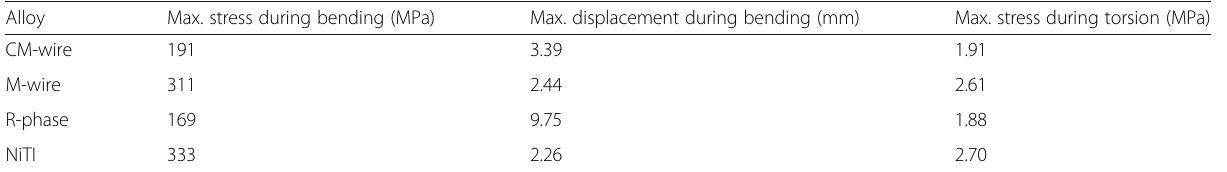
Table 1 Showing the maximum stresses value during bending and torsion and showing the maximum displacement during bending of files with different metallurgy